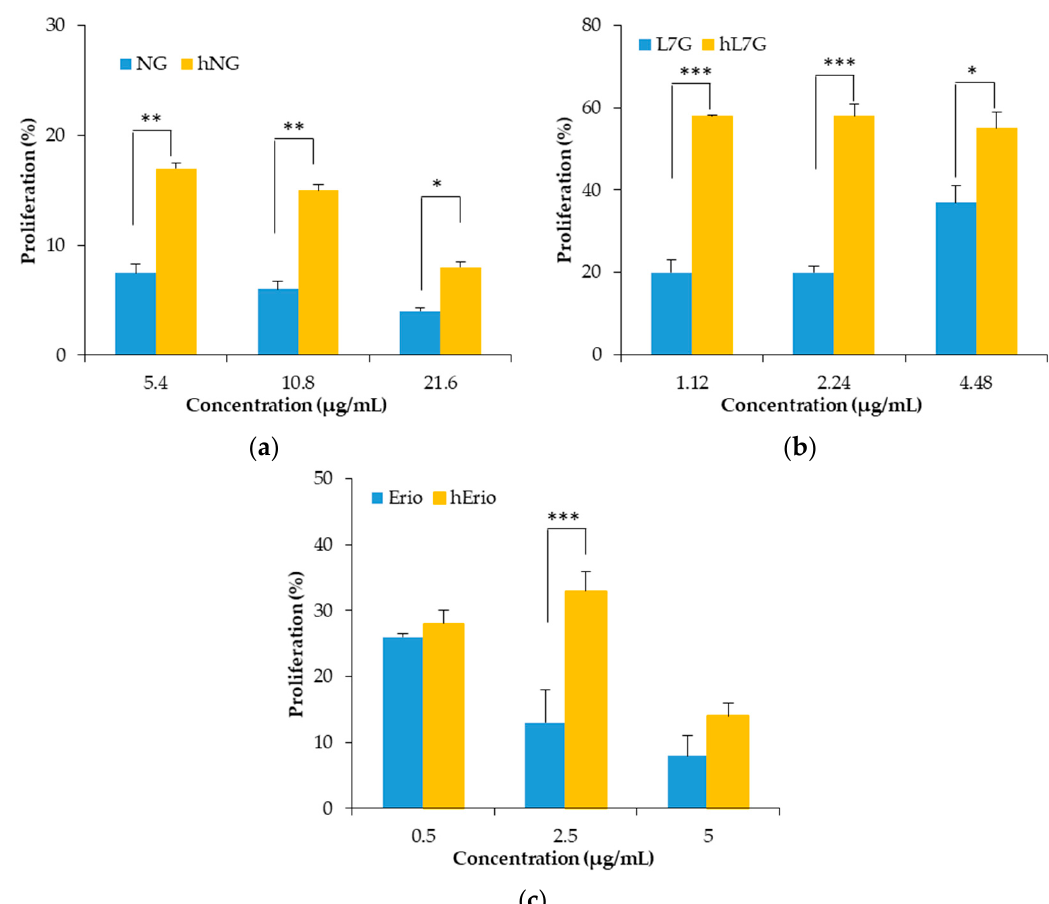
Figure 6. Effects of heated flavonoids and native flavonoids on spleen proliferation responses. ( a ) naringin (NG) and heated naringin (hNG), ( b ) luteolin 7- O -glucoside (L7G) and heated luteolin 7- O -glucoside (hL7G), ( c ) eriodictyol (Erio), and heated eriodictyol (hErio).